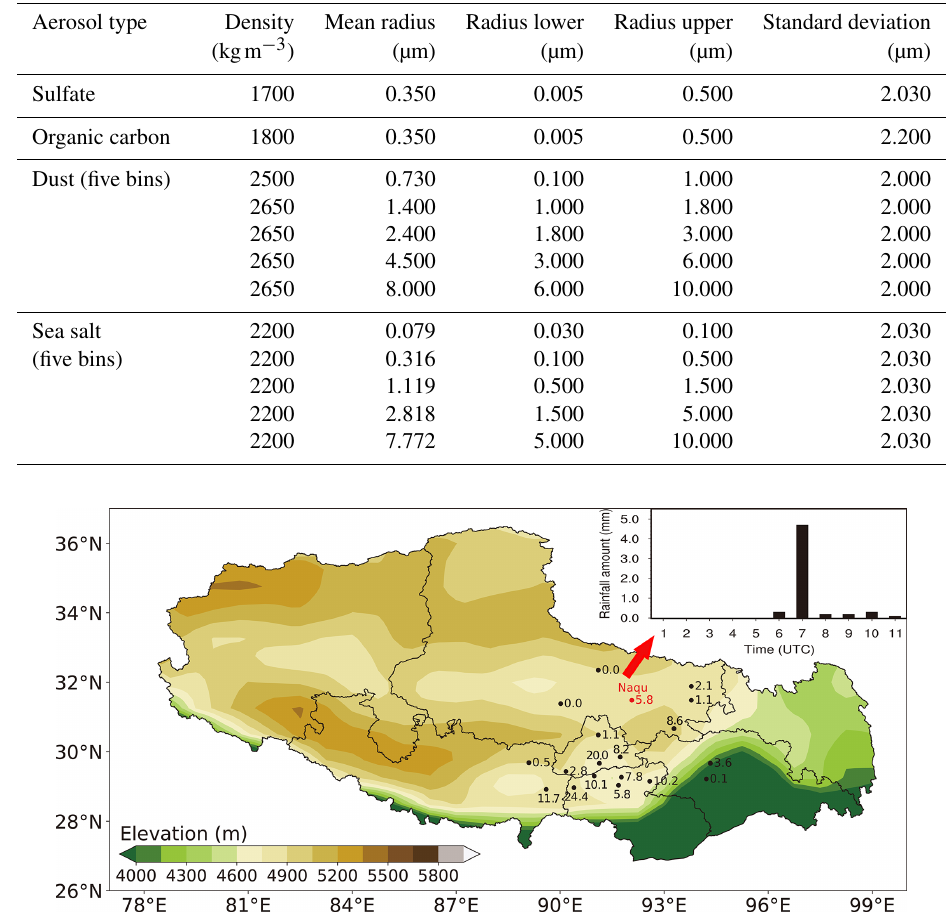
Table 1. Aerosol particle radius, standard deviation, and density.